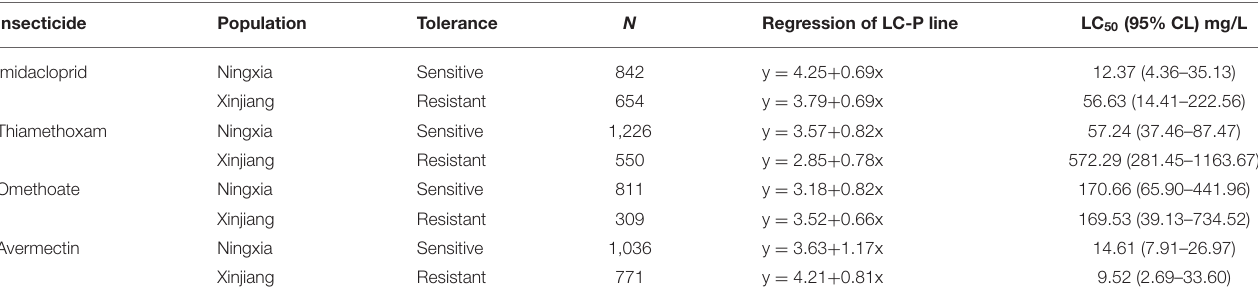
TABLE 3 | Toxicology experiment of